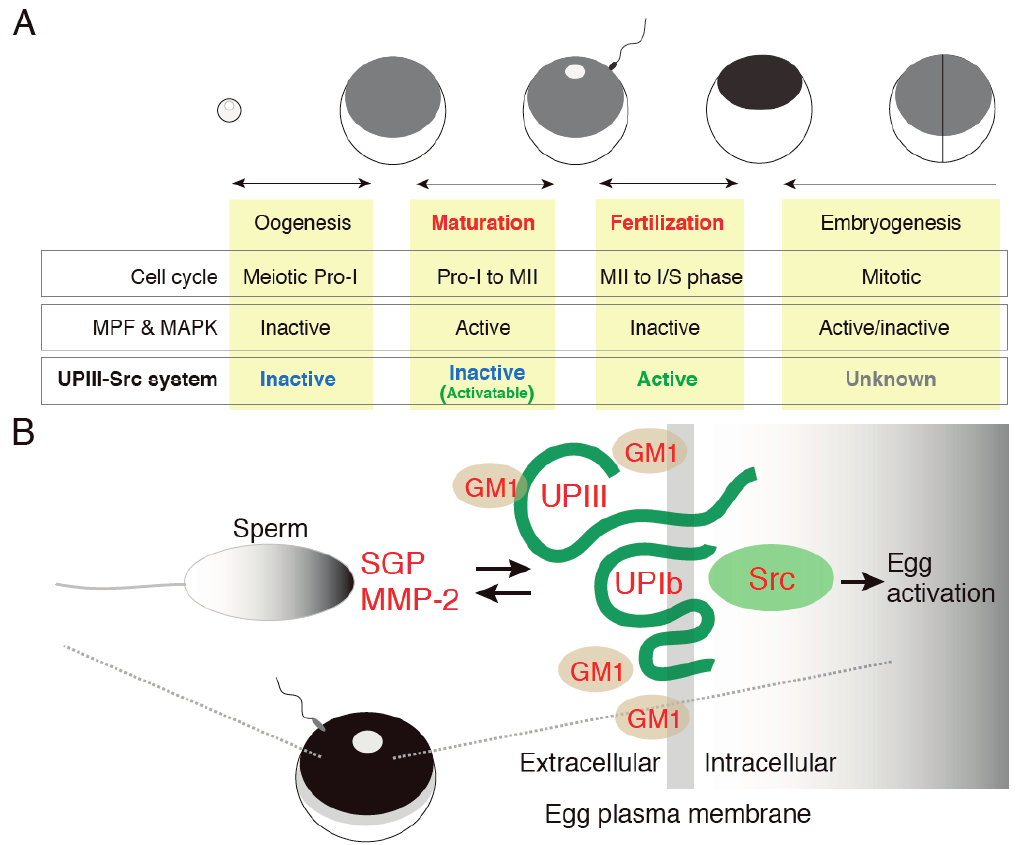
Figure 1. Egg membrane microdomain-associated UPIII-Src system in Xenopus laevis . ( A ) Shown is a schematic diagram for the cell cycle conditions, and the activation/inactivation switching of the MPF (maturation-promoting factor), MAPK (mitogen-activated protein kinase), and UPIII (uroplakin III)-Src system, in the course of oogenesis, oocyte maturation, fertilization, and early embryogenesis in Xenopus laevis ; ( B ) Illustrated are sperm-egg interaction at the level of each gamete’s plasma membrane and its associated signaling events that involve SGP (sperm surface glygoprotein) and MMP-2 (matrix metalloproteinase-2) in sperm and UPIII/UPIb (uroplakin Ib) complex, GM1, and Src in eggs. For details, see main